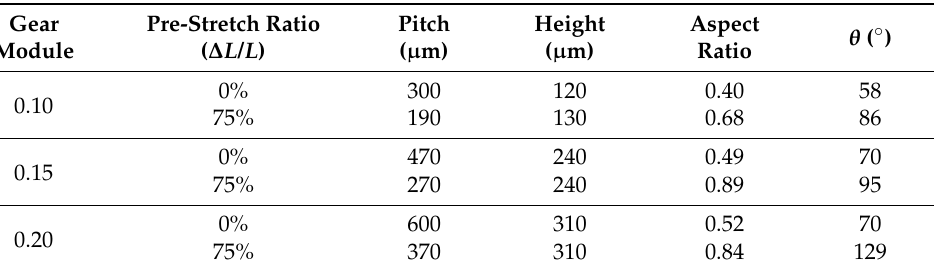
Figure 6. Prediction of stretchability based on SEM observed value in changing the gear module and with or without pre-stretch.